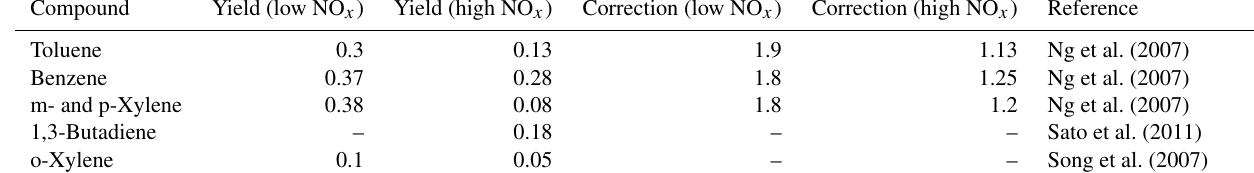
– – – – Song et al. (2007)